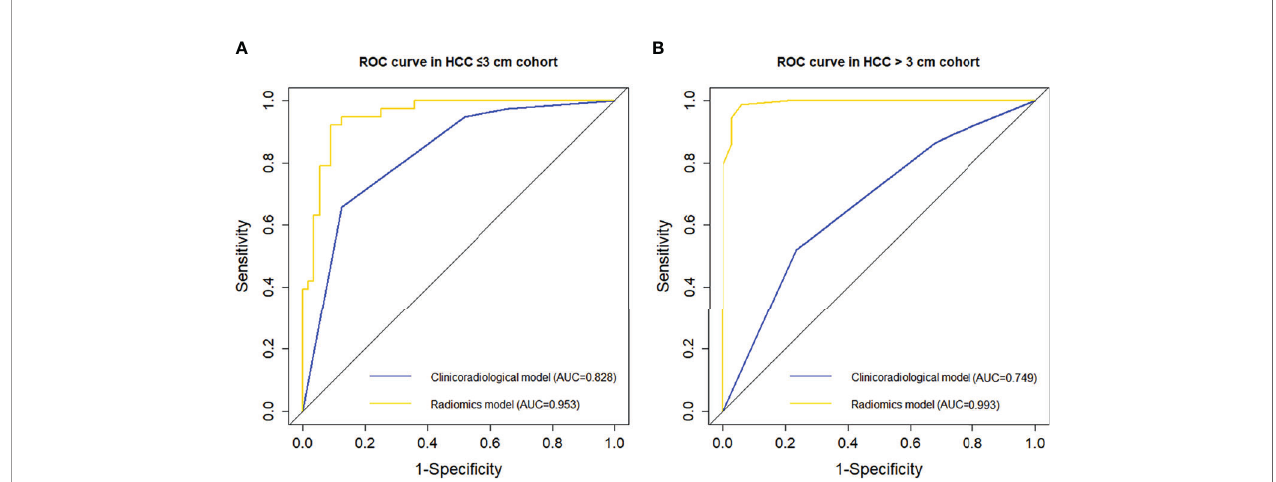
FIGURE 5 | Comparison of receiver operating characteristic (ROC) curves in predicting MVI presence in the subgroups. ROC curves of the clinicoradiological model and radiomics model in the (A) HCC ≤ 3 cm and (B) HCC > 3 cm